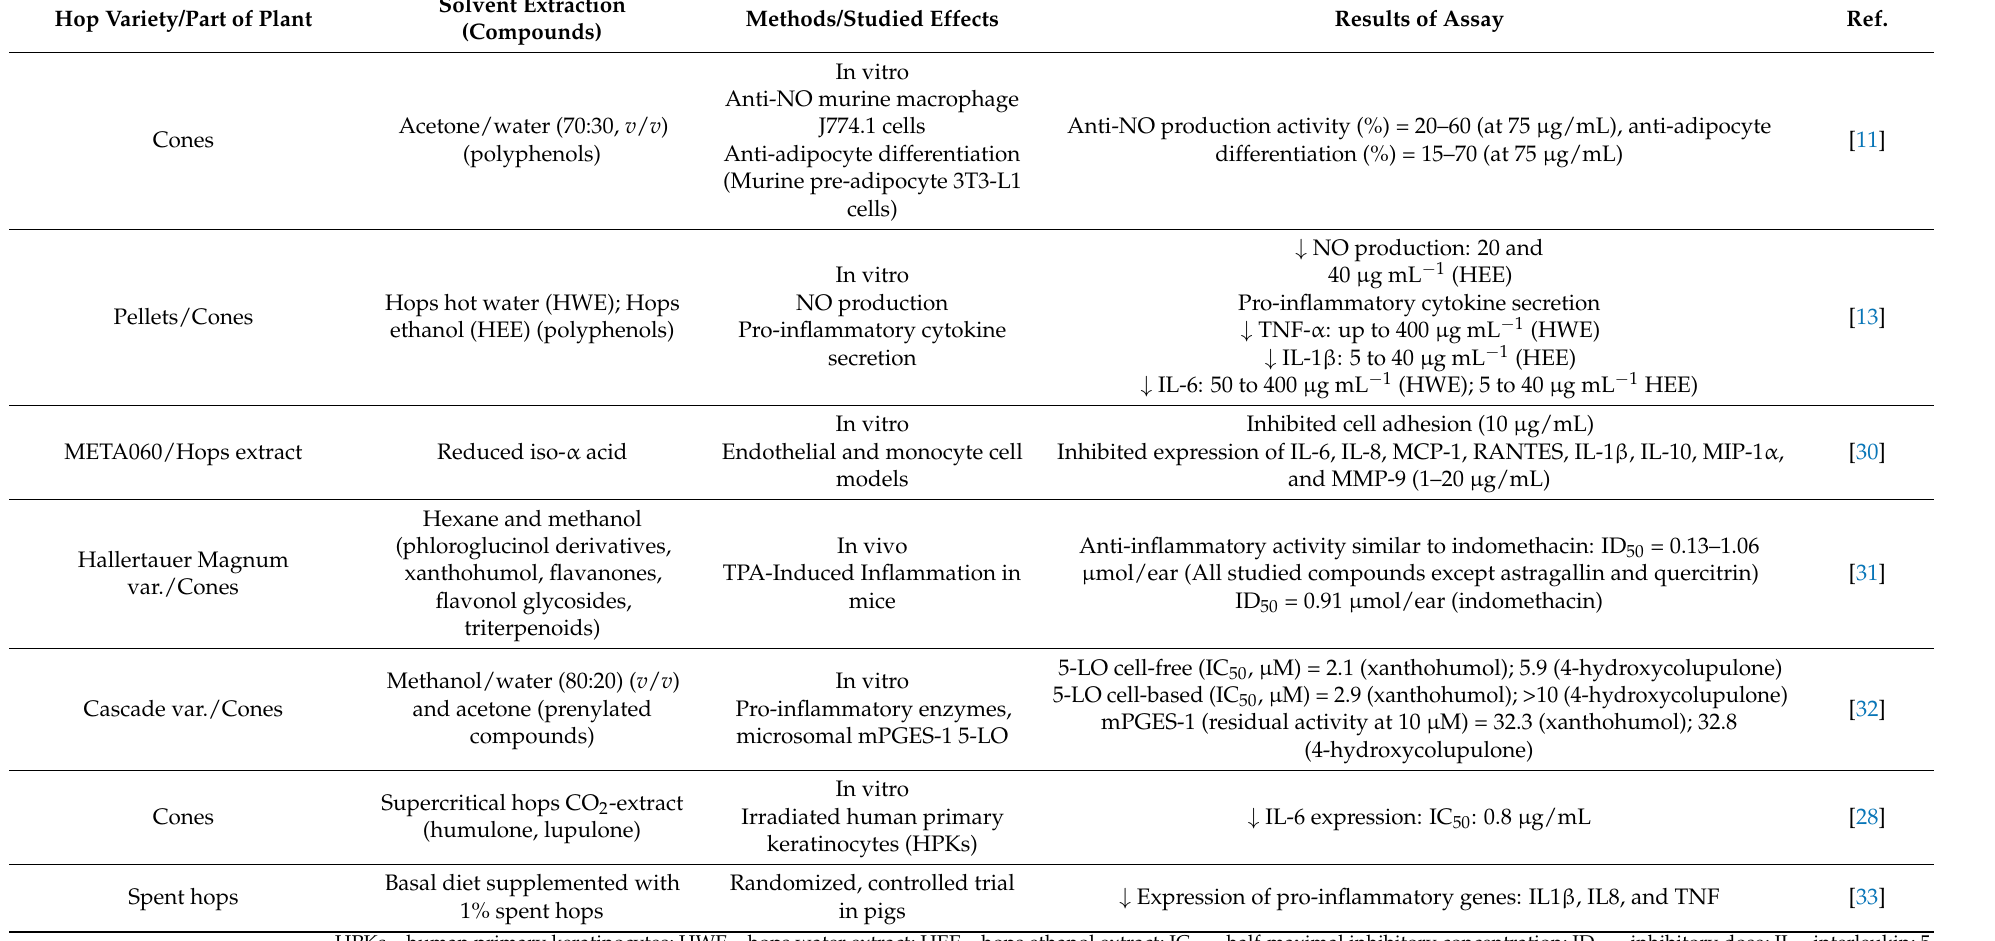
Table 2. Anti-inflammatory activities of hop